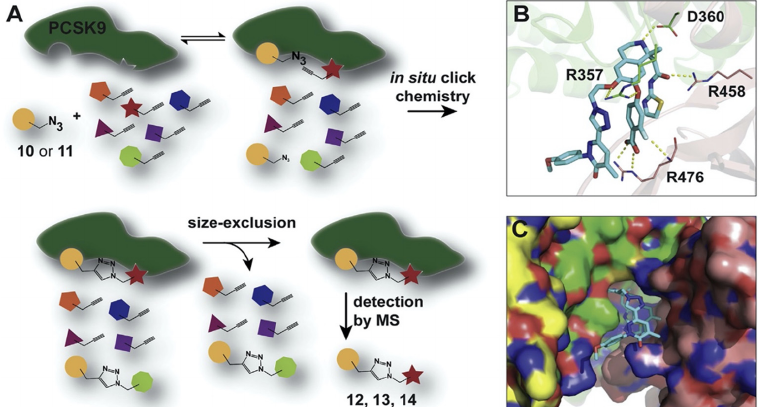
Figure 5. Illustration of PCSK9-mediated and -guided cycloaddition and X-ray complex with com- pound 14 (Petrilli, WL et al., 2020, [59]). ( A ) PCSK9 is incubated with modified azide, with several alkynes differing in molecular weight. If both azide and alkyne bind to the PCSK9 allosteric site in proximity to each other, 1,3-dipolar cycloaddition is promoted. Nonreacted compounds as well as nonbinding products were removed by size-exclusion chromatography, whereas MS was employed to determine the precise mass of the binder alkynes. ( B ) Specific interactions of compound 14 with PCSK9 at an allosteric binding site. ( C ) Spatial orientation of solvent-exposed substituent at C6 of compound 14 (PDB: 6U36). Interaction of pyranic oxygen with R357 can also be seen.